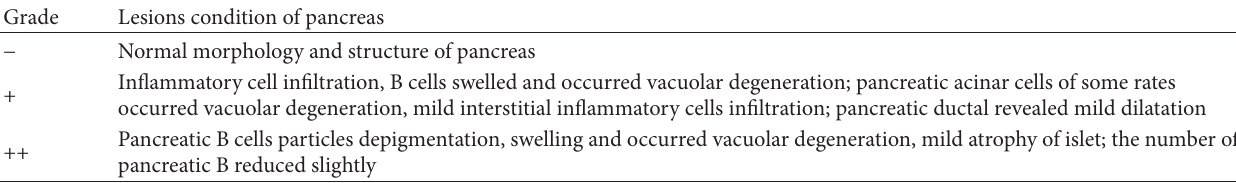
Table 4: Pancreatic endoscopic diagnostic criteria.